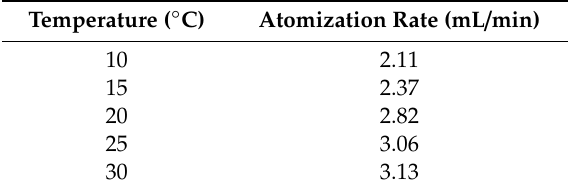
Figure 13. Relationship between the atomization rate and temperature. Table 5. Atomization rate of pure water at di ff erent